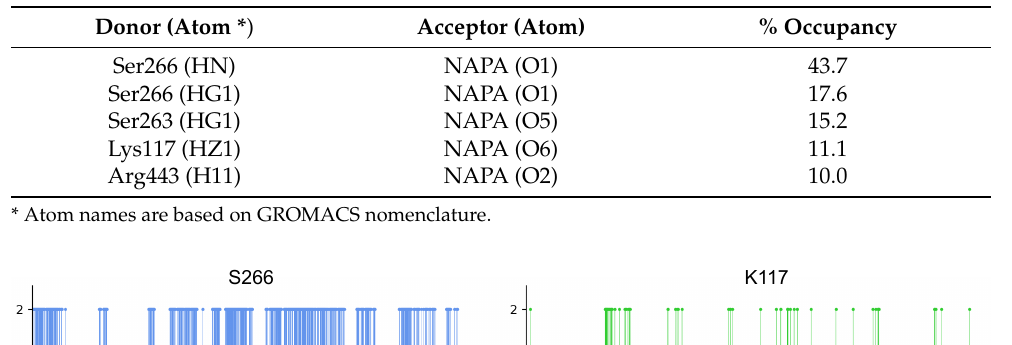
Table 1. Occupancy rates of the stable interactions belonging to the H-bonding network found in IKK α -NAPA complex during the MD simulation, starting from 150 ns to 300 ns. Hydrogen bonds with values of percentage occupancy higher than 10% were considered as a significant non-covalent interaction for the molecular stabilization of the IKK α -NAPA complex [50].